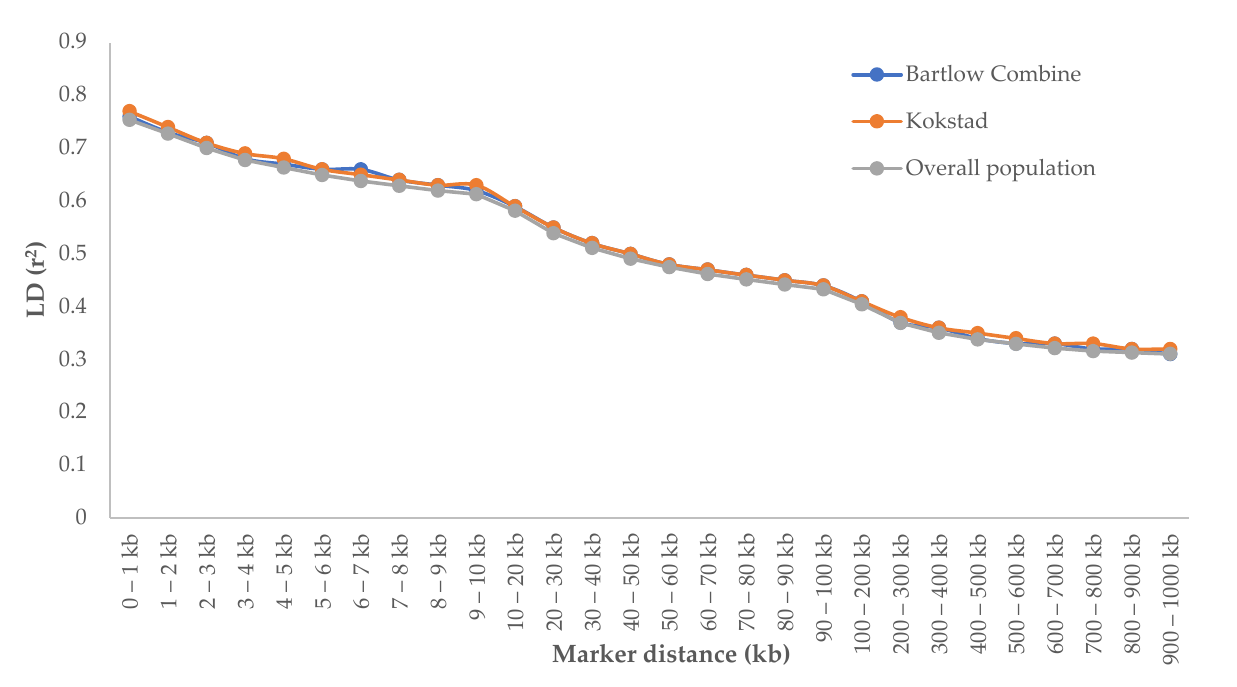
Figure 3. Linkage disequilibrium ( r 2 ) between adjacent SNPs pairs separated by different distances in Bartlow Combine, Kokstad, and overall Nguni cattle populations.